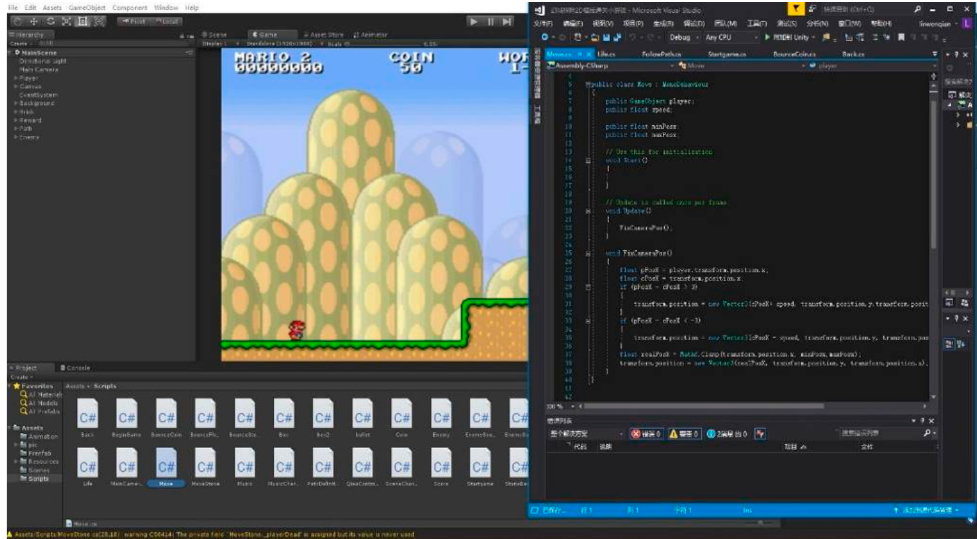
Figure 3. Interactive game based on Unity3D.